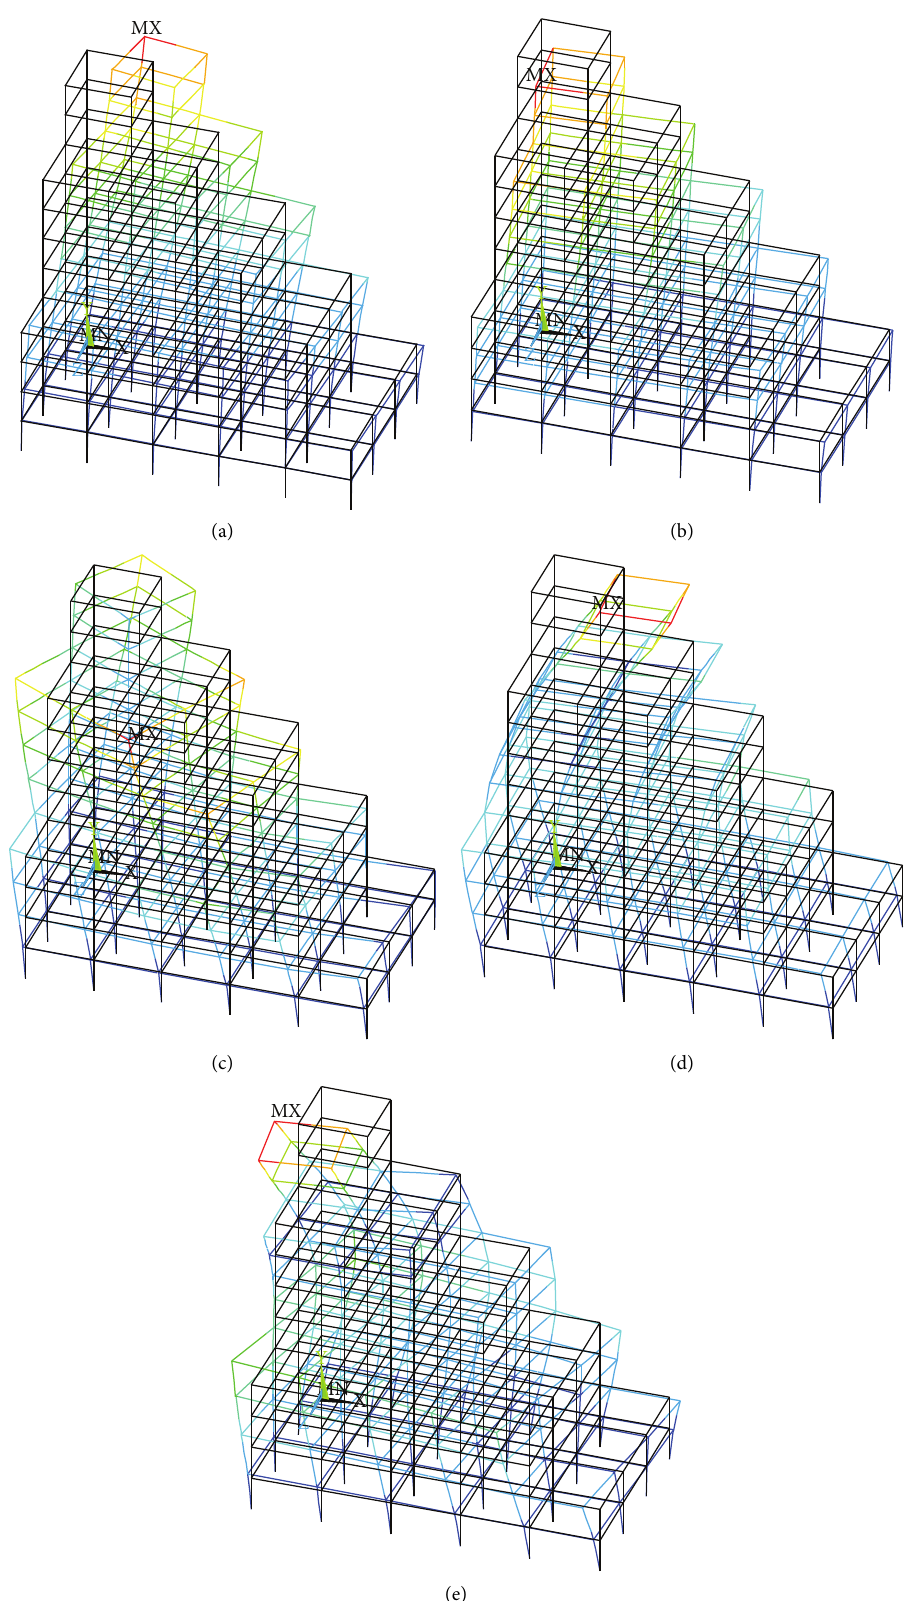
Figure 4: First 5 modes of setback building model. (a) 1st mode (1.0Hz). (b) 2nd mode (1.08Hz). (c) 3rd mode (1.65Hz). (d) 4th mode (2.41 Hz). (e) 5th mode (2.86